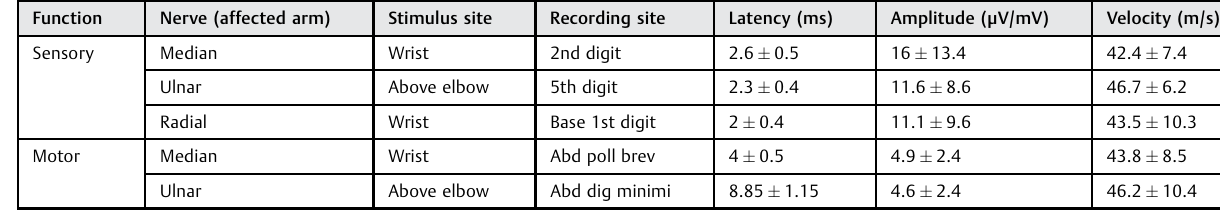
Table 3 Summary of preoperative nerve conduction studies Function